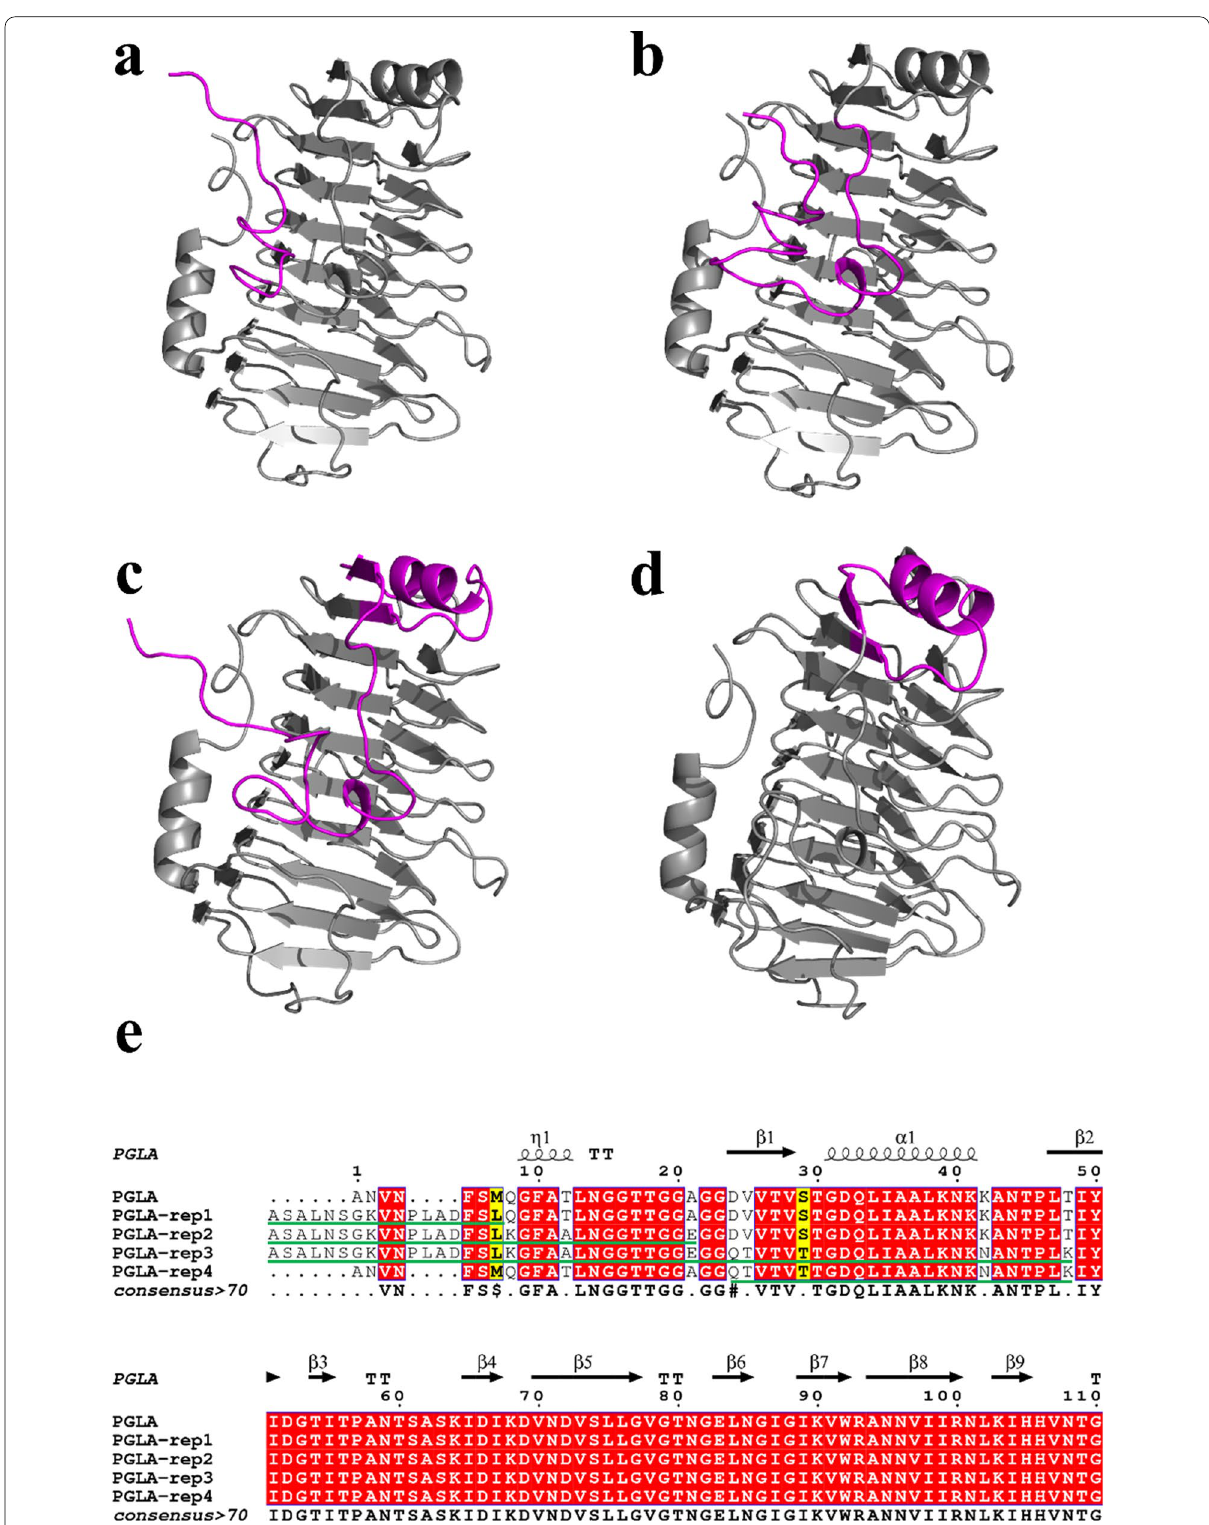
Fig. 1 The three‑dimensional structure and multiple sequence alignment of the modified alkaline pectin lyase a PGLA‑rep1, b PGLA‑rep2, c PGLA‑rep3, d PGLA‑rep4, e Constructed 5 sequence alignment maps, The part drawn with a green horizontal line is the part of the replacement fragment—the purple part in the 3D structure depicts replacement